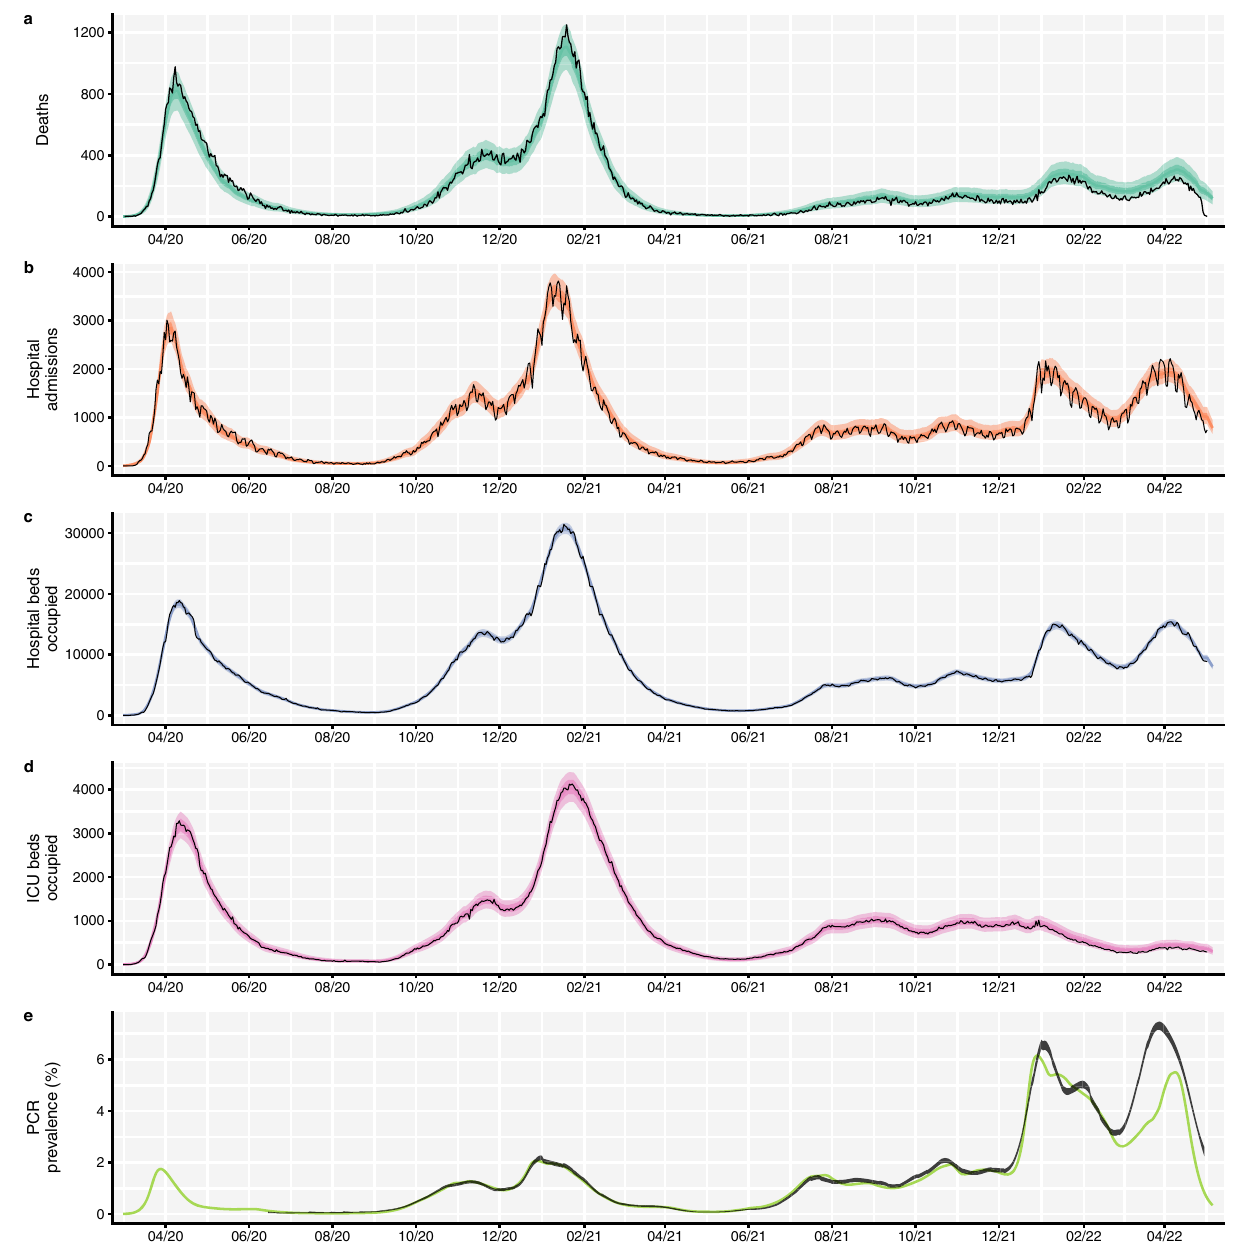
Fig. 2 | Comparison between aggregated model fi ts and epidemiological data from England between March 2020 and May 2022. Black lines show reported data, with black ribbons showing 95% con fi dence intervals for PCR prevalence. Coloured lines and shaded areas show medians, 50% and 90% interquantileranges from the fi tted model. The original model fi tting is done independently for each NHS England region (see Fig. S1A, B), with the aggregated model output for the whole of England shown here. a COVID-19 deaths over time, where data was pro- vided by the UK Health Security Agency (UKHSA). b COVID-19 hospital admissions over time, where data was provided by NHS England. c COVID-19 hospital bed